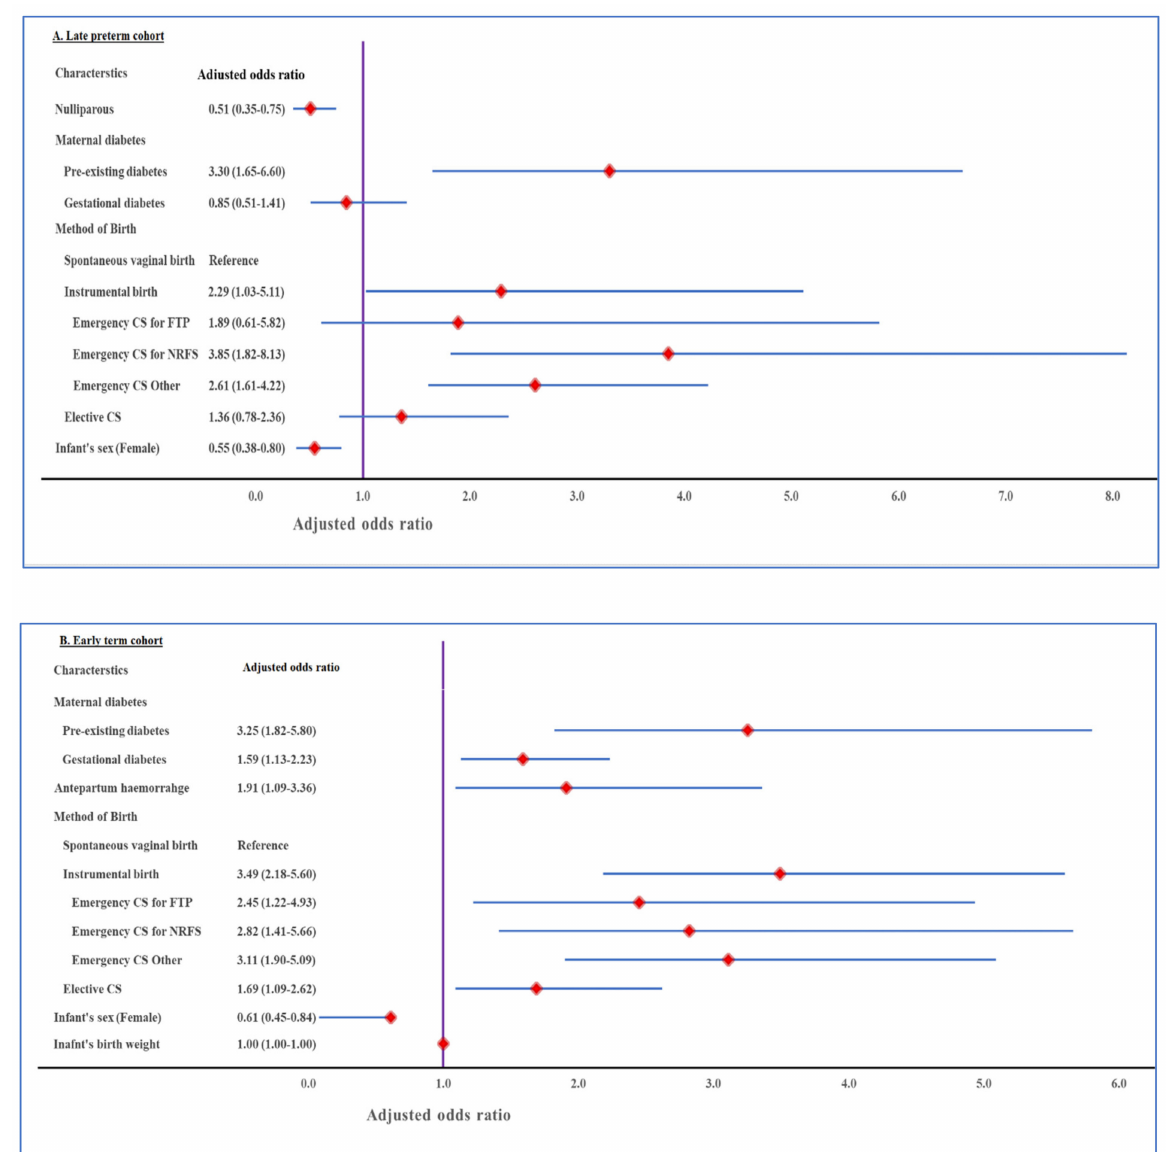
Figure 3. Adjusted associations of risk factors with early severe neonatal morbidity (SNM) in late preterm ( A ) and early term ( B ) infants. A—adjusted for: maternal age, ethnicity, gestational age at birth in weeks and B—adjusted for maternal age, ethnicity, maternal body mass index, SEIFA Score and gestational age at